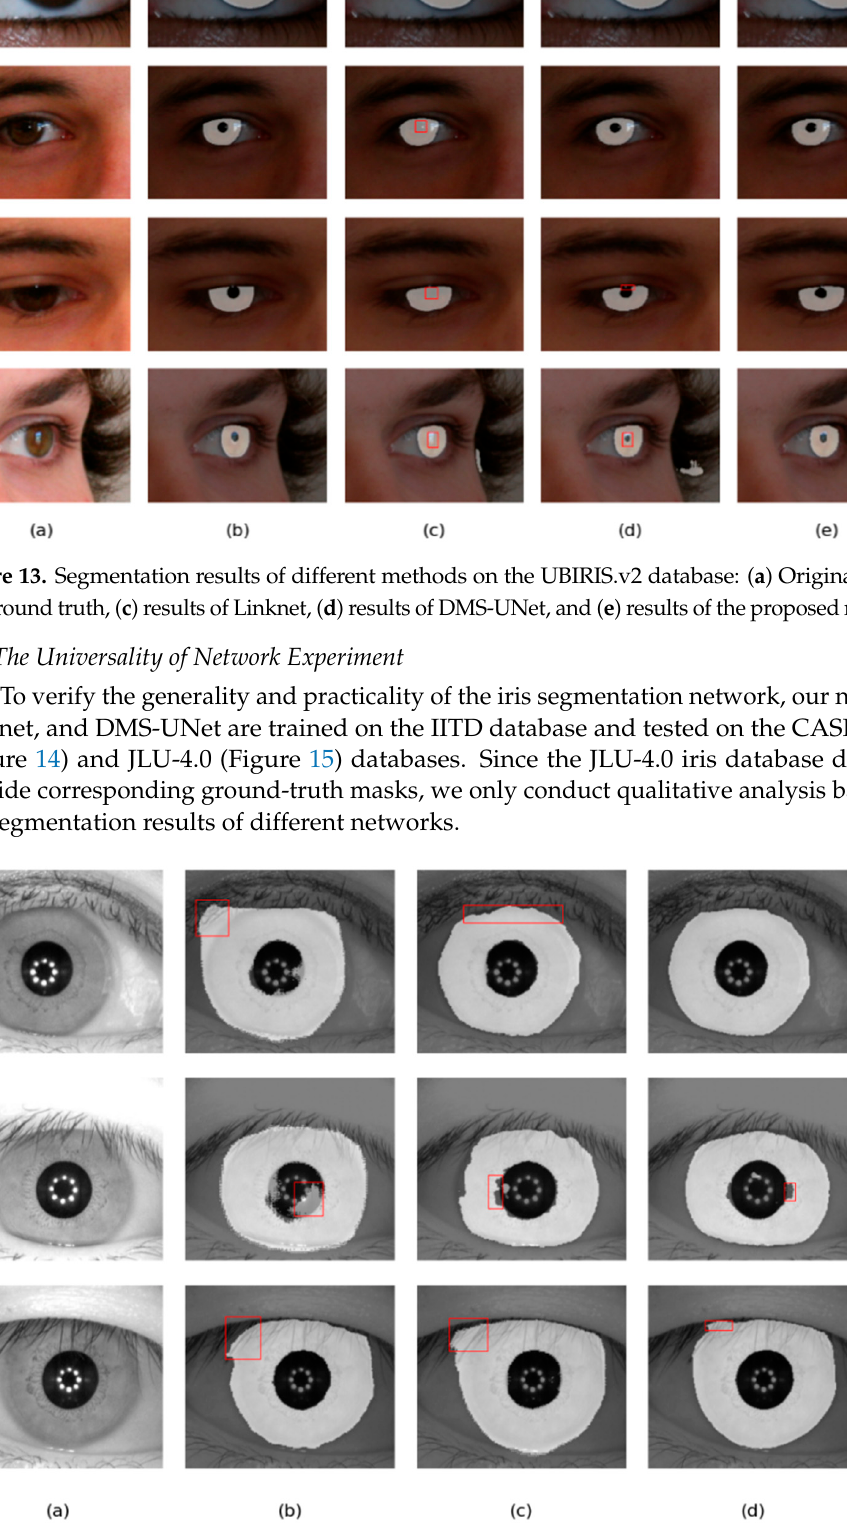
Figure 14. Segmentation results of different methods on the CASIA-V4.0 database: ( a ) Original image, ( b ) results of Linknet, ( c ) results of DMS-UNet, and ( d ) results of the proposed network.